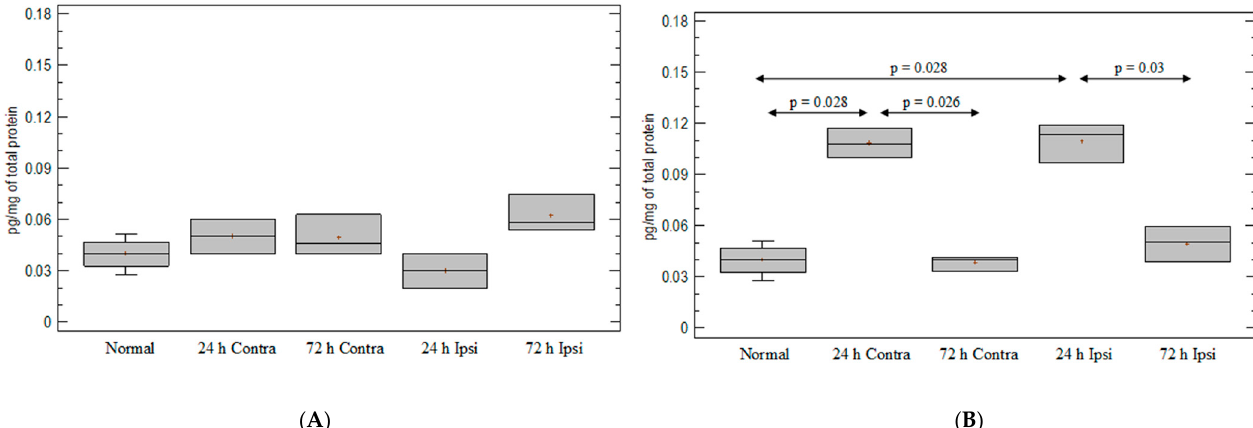
Figure 6. CXCL12 expression in mouse brain after ( A ) PBS injection and ( B ) KA injection. Brains were collected 24 h and 72 h postinjection. Ipsi—ipsilateral hemisphere; Contra—contralateral hemisphere; Normal—control animals without any injection.